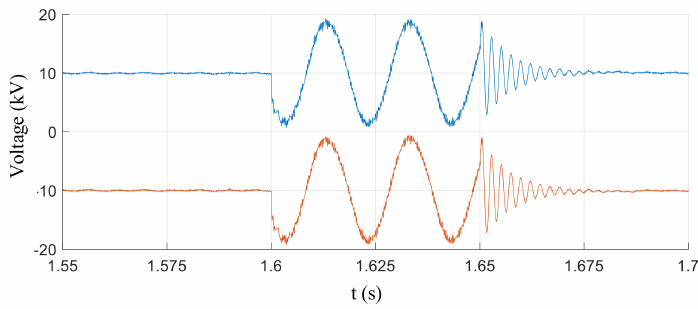
Figure 12. Single-pole to ground voltage waveform of the DC